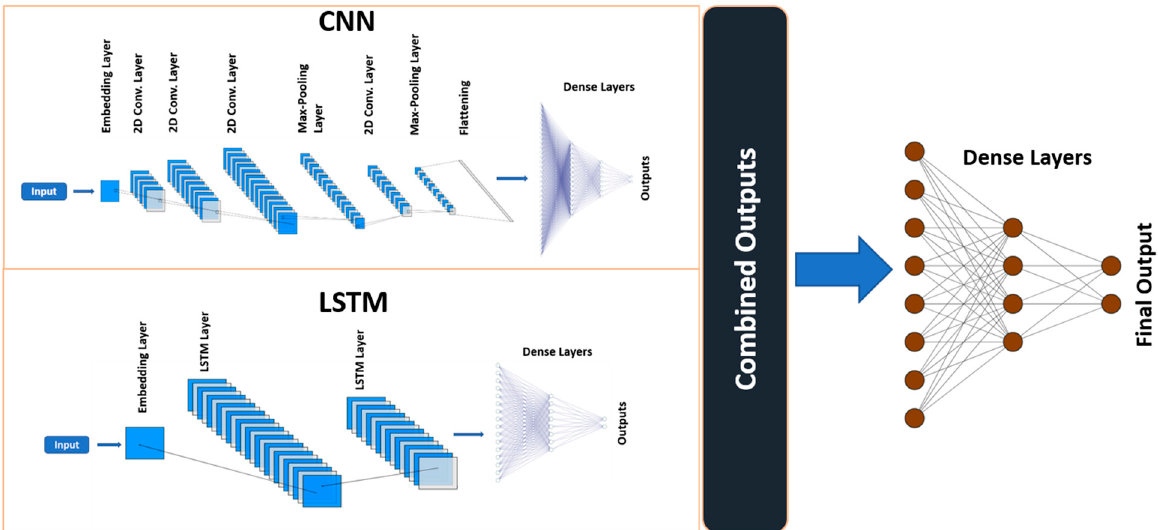
Figure 2. Stacking ensemble model combining 10 models from 10-fold cross-validation.